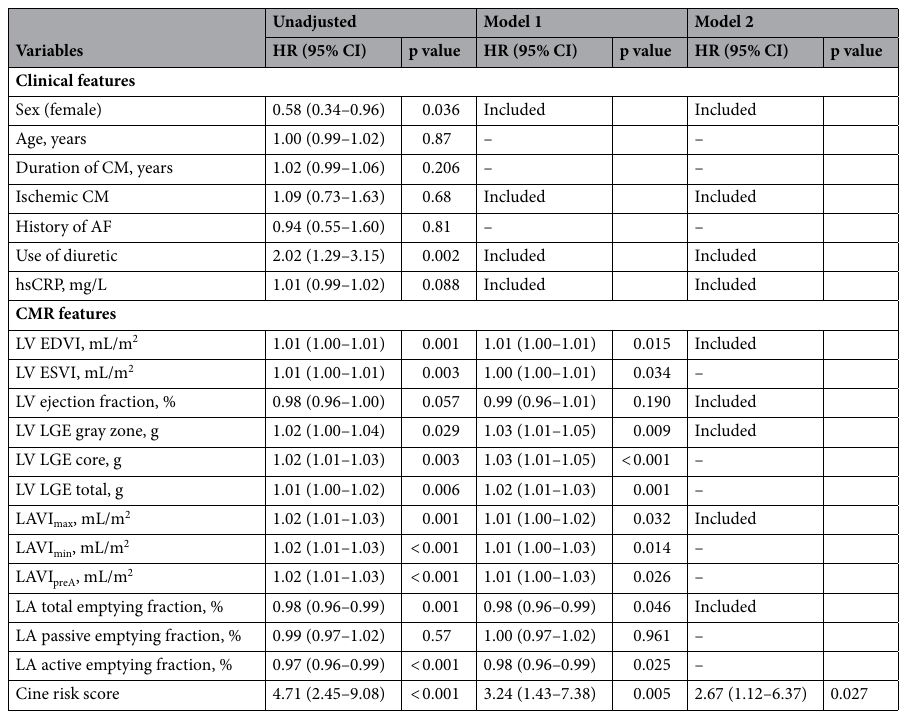
Table 5. Predictors of ventricular arrhythmia by unadjusted and adjusted Cox proportional regression analysis. Model 1 each CMR feature is adjusted for sex, type of CM, use of diuretics, and hsCRP in separate models. Model 2 fully adjusted multivariable model incorporating Model 1, LVEDI, LV ejection fraction, LV LGE gray zone, LA maximum volume index and LA total emptying fraction. HR hazard ratio, CI confidence interval, CM cardiomyopathy, AF atrial fibrillation, hsCRP high-sensitivity C-reactive protein, CMR cardiac magnetic resonance, LV left ventricular, EDVI end-diastolic volume index, ESVI end-systolic volume